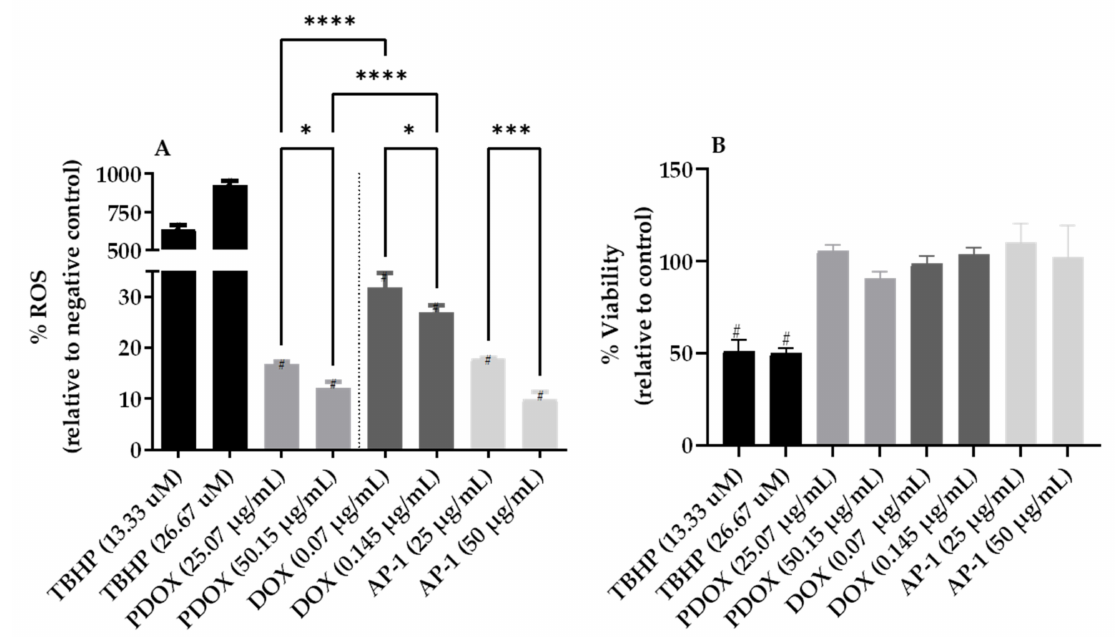
Figure 5. Relative ROS production in MCF7 ( A ) and its percentage viability ( B ) compared to the negative control, upon treatment with Australian propolis (AP-1), doxorubicin (DOX), their synergistic combination (PDOX) and the positive control tert-Butyl hydroperoxide (TBHP). Values expressed as mean ± standard deviation (SD) ( n = 3), One-way ANOVA was used for multiple comparisons, #; statistically significant relative to negative control ( p < 0.0001), *; p < 0.05, ***; p < 0.001, ****; p <